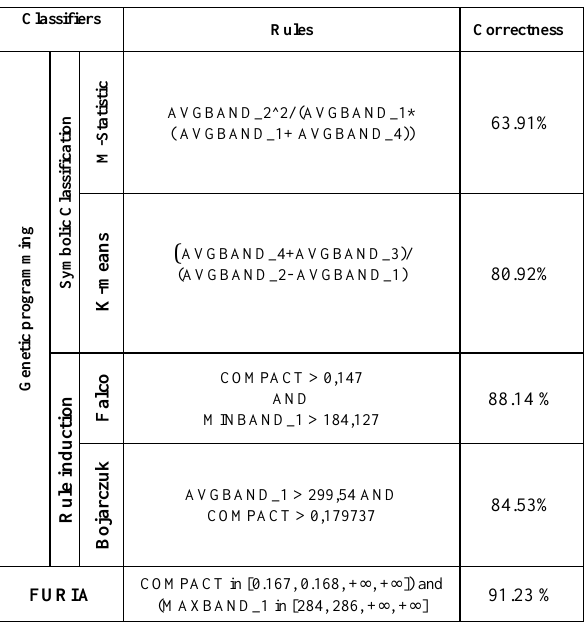
Table 4. Results of separating buildings from